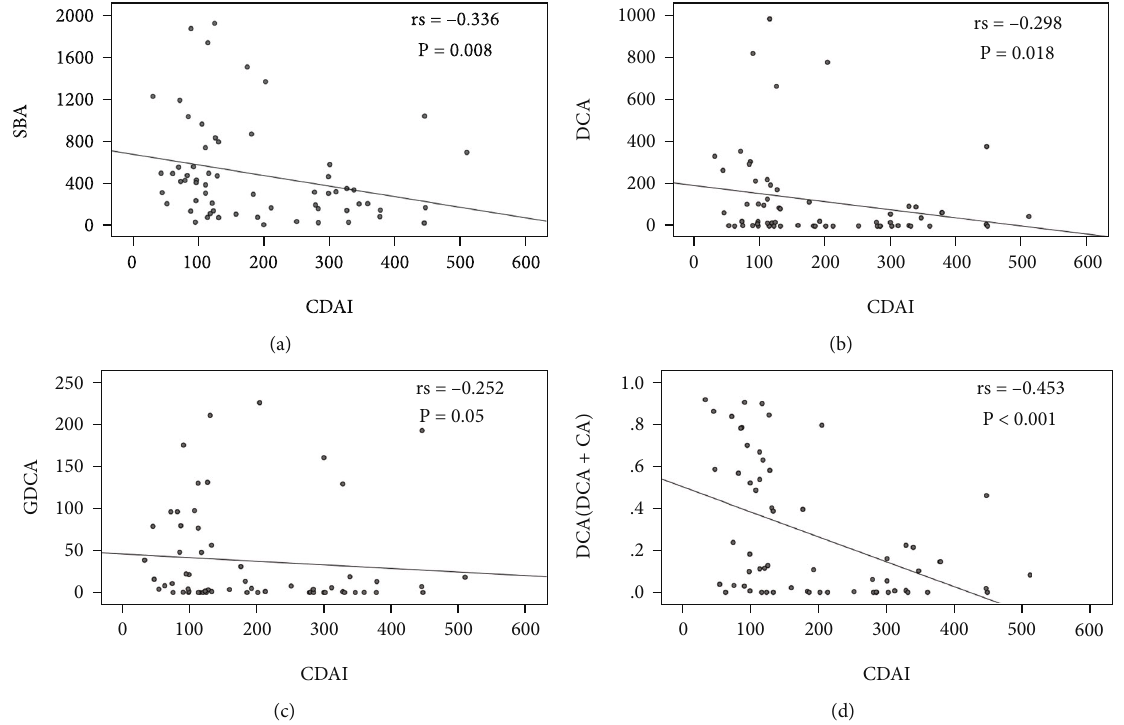
Figure 5: Correlation of laboratory biomarkers and bile acid markers with disease activity in CD